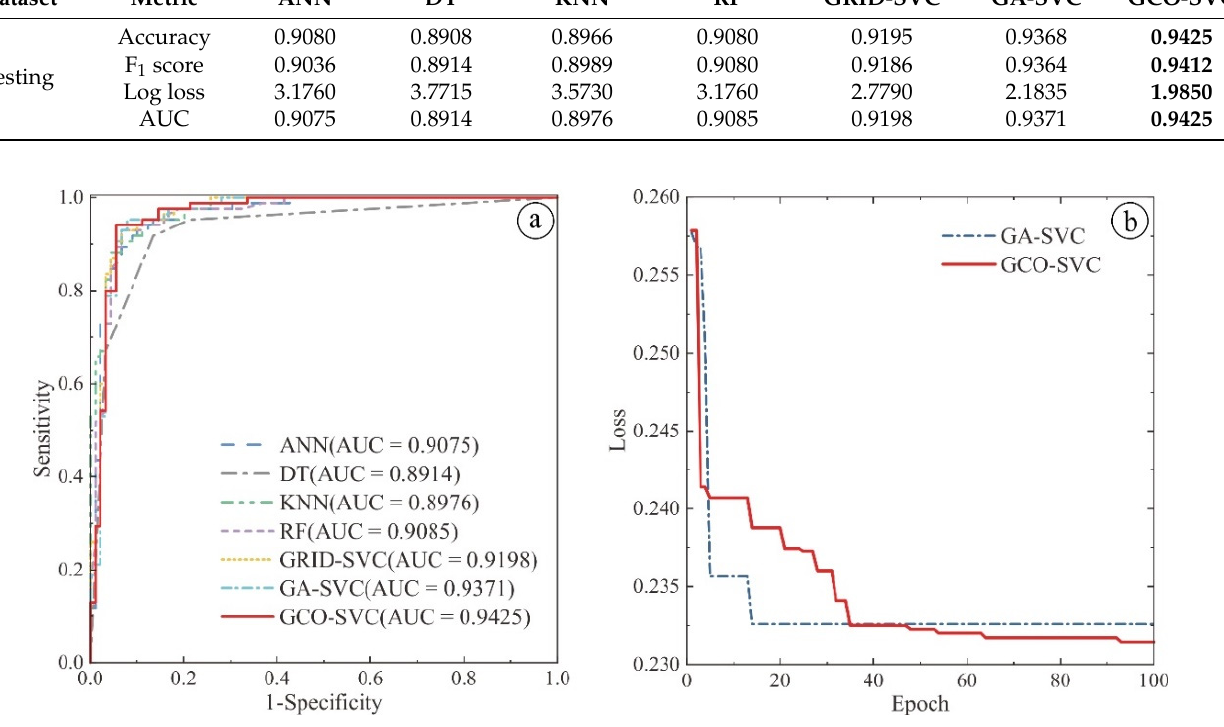
Figure 7. Model performance: ( a ) ROC curves of the seven models on the testing set and ( b ) loss of the GA-SVC and GCO-SVC models.